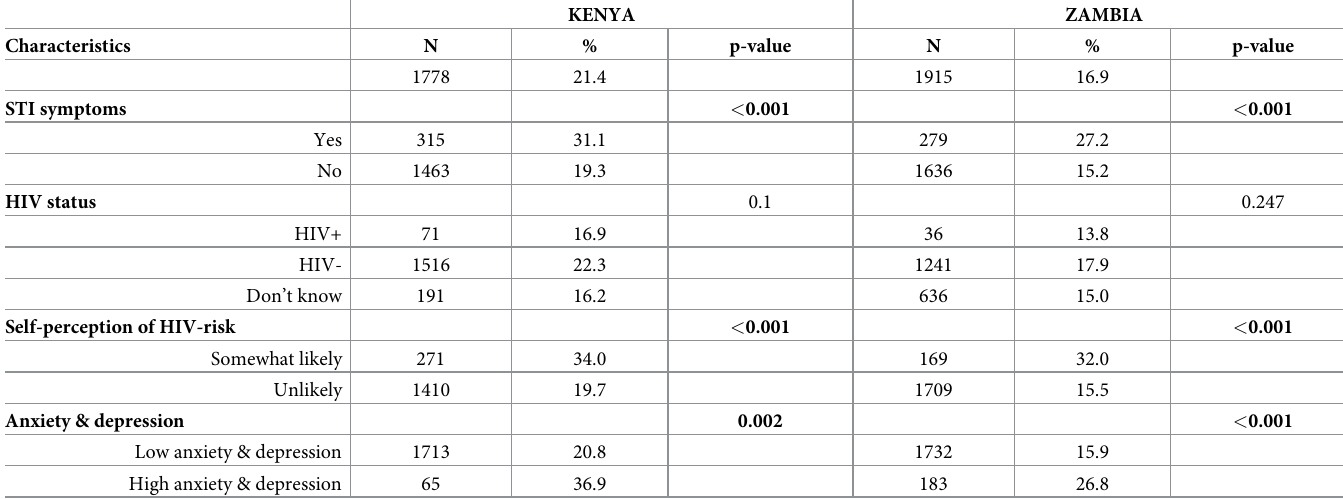
Table 4. Bivariate associations between experience of non-partner sexual violence and health outcomes, Kenya and Zambia.